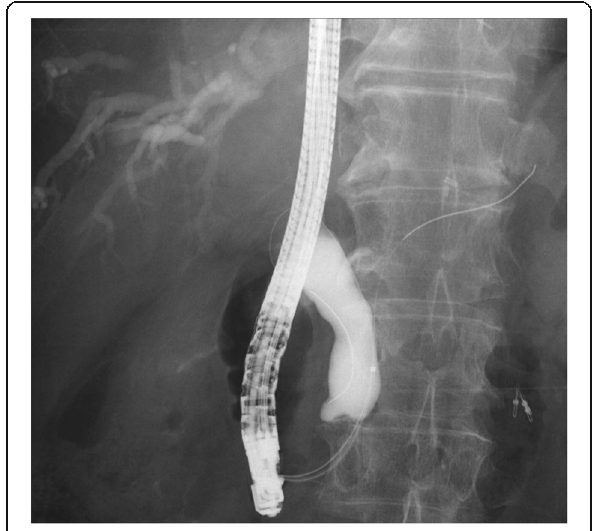
Fig. 2 Endoscopic retrograde cholangiopancreatography showed narrowing of the distal bile duct and dilation of the peripheral bile duct, and abrasion cytology was